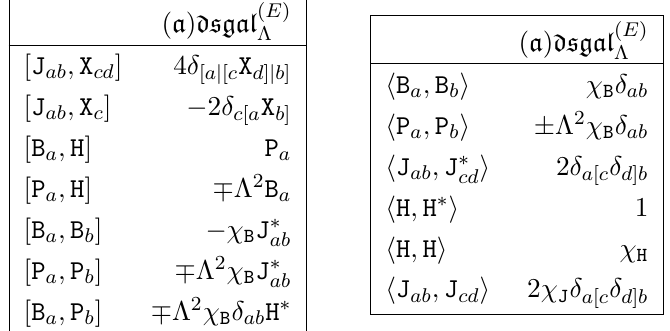
Table 7 . Double extension based on the AdS-galilean (upper sign) and dS-galilean (lower sign) spacetimes in D + 1 dimensions and its invariant metric. The vector X a stands for B a , P a ; the tensor . The bilinear form is nondegenerate if (cid:31) X ab for J ab , J (cid:3) ab